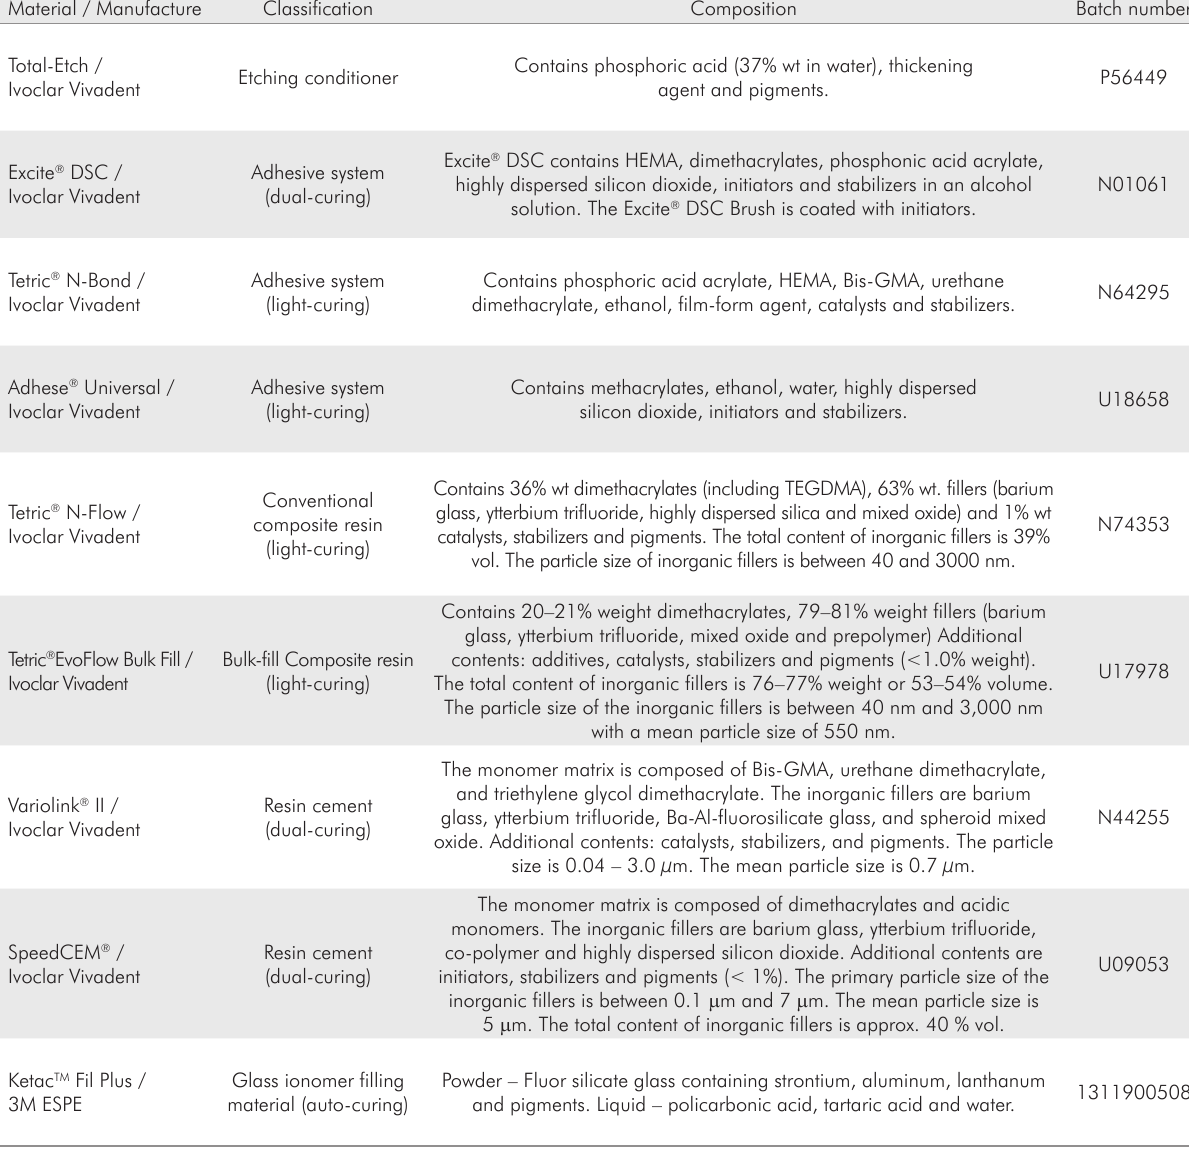
Table 1. Composition, classification and batch number of the materials. Material / Manufacture Classification Composition Batch